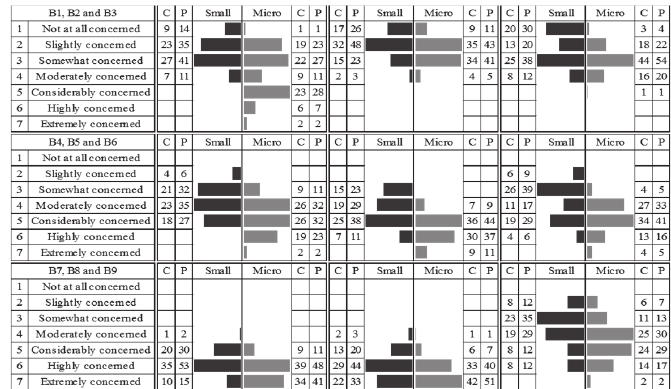
Fig. 1. Frequency Distribution Visual- Level of concern towards the power system reliability and quality issues based on the size of the industry Section O: Respondents were asked about the level of disruptiveness on a seven-point Likert item scale towards the occurrence of one hour outage due to the reliability issues of different nature mentioned below from O1 to O5 on your business.